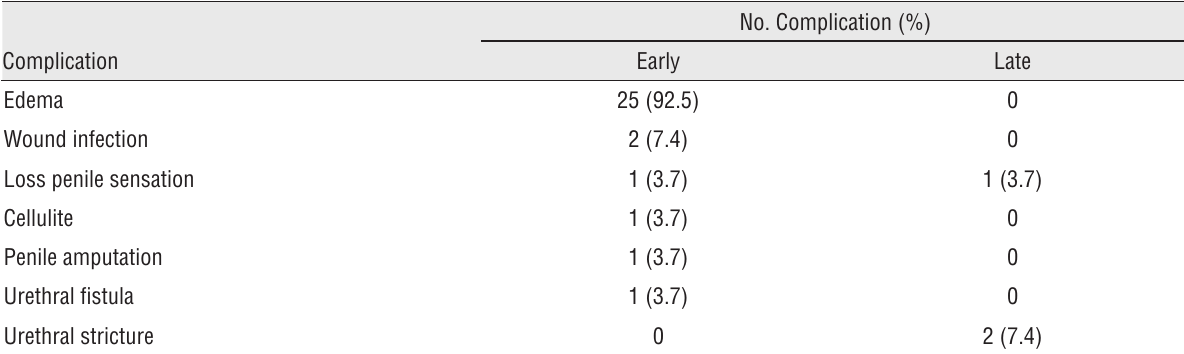
Table 2 - Early and late complications after penile constrictor release.